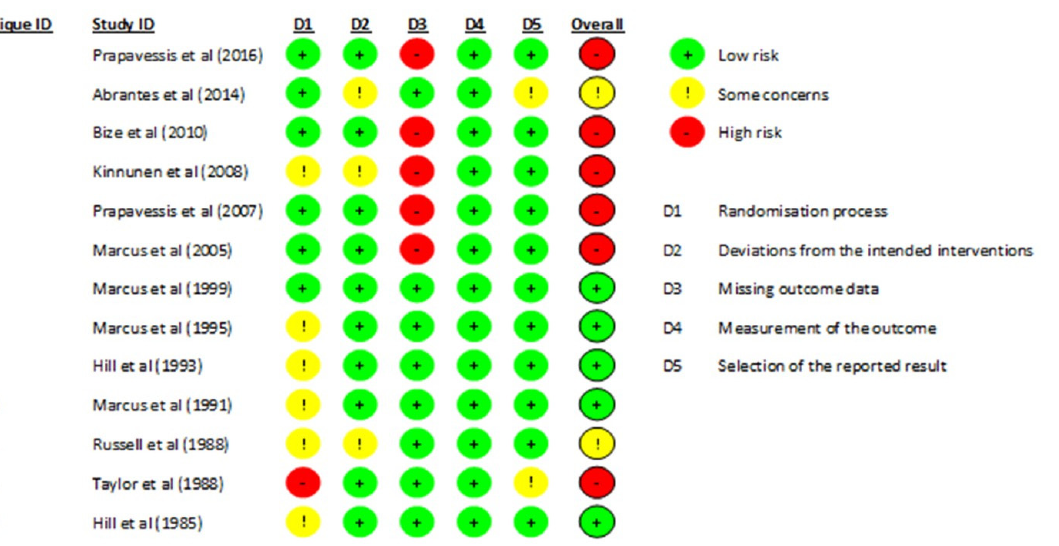
Figure 3. Forest plot for the success of Smoking cessation (SC). CI: confidence interval; Ev: number of quitters in the exercise group/s at the last follow-up session; Trt: number of participants in the exercise group at baseline; Ctrl: number of participants in the non-exercise group/s at baseline session. References cited in the figure are: [37–48]. 4.2. Effects of Exercise during Smoking Cessation Interventions on VO 2max and/or VO 2peak A meta-analysis of 5 trials (three high, one moderate and one low quality) [41,45–47] showed that aerobic exercise during smoking cessation interventions resulted in a higher VO 2max and/or VO 2peak than the other groups post intervention (Figure 4). No significant